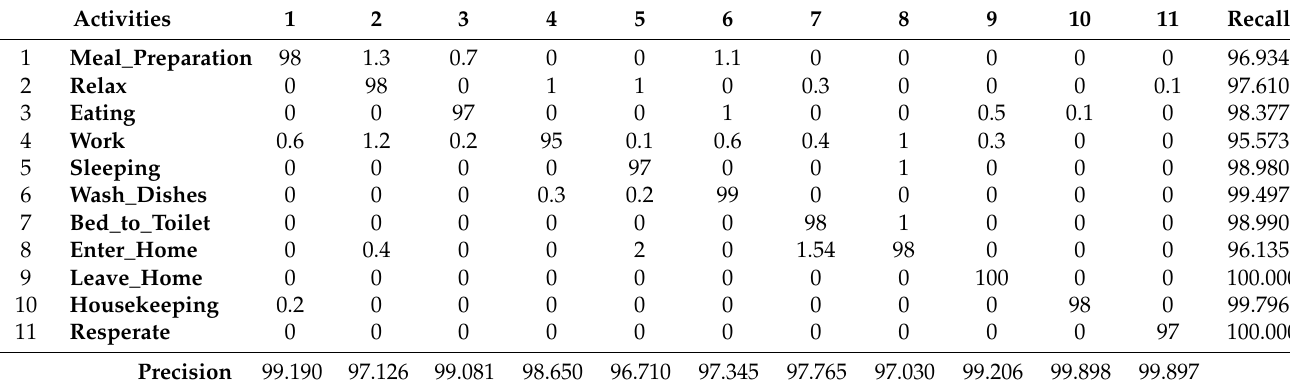
Table 5. Confusion matrix for